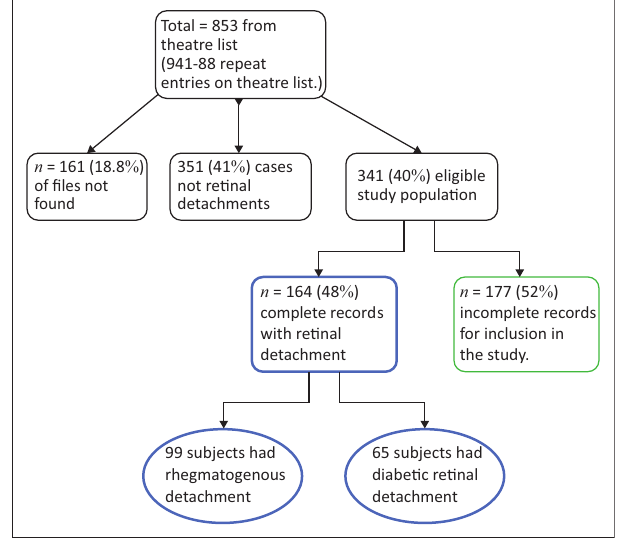
FIG URE 1: Flow diagram of the study